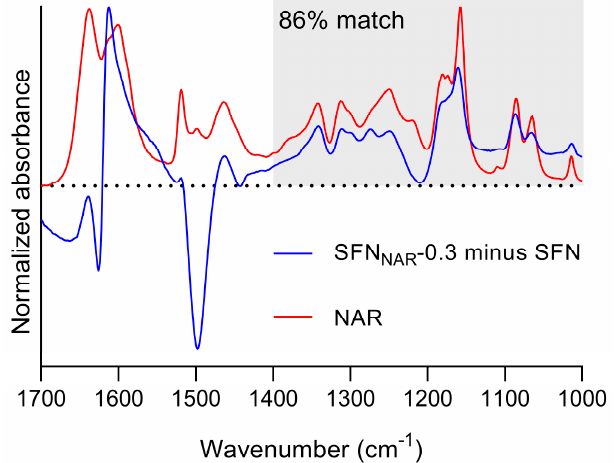
Figure 1. Specificity of ATR-FTIR spectroscopy for identifying drugs in silk fibroin nanoparticles (SFN). In blue, the resulting spectrum after subtraction of the SFN spectrum from the SFN NAR -0.3 spectrum. In red, the spectrum of NAR measured from a dried film. The gray rectangle shows the area used for